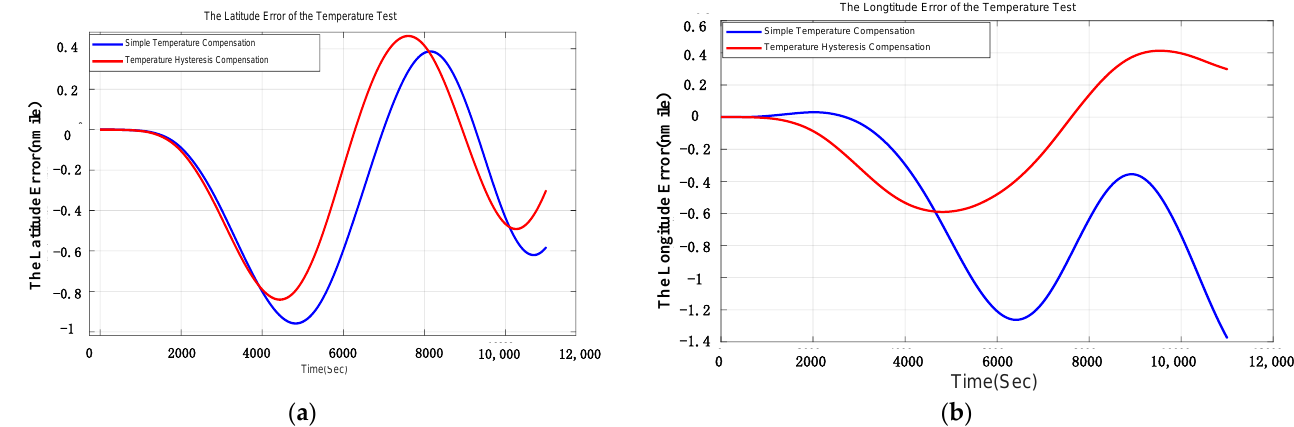
Figure 10. ( a ) is the comparison of longitude error in laboratory test; ( b ) is the comparison of latitude error in laboratory test.